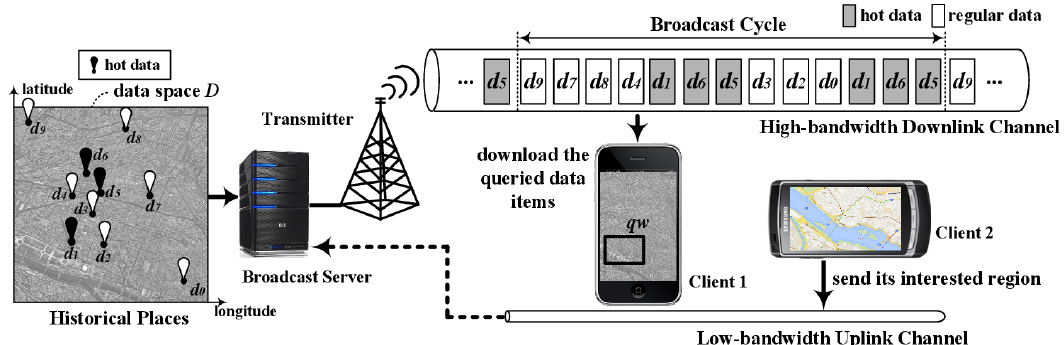
Figure 1. A system for the non-flat broadcast of spatial